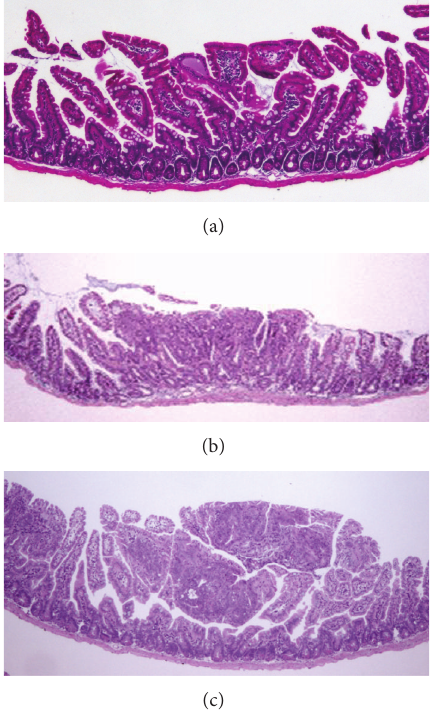
Figure 2: Histological aspects of adenomatous mucosa. H-E sec- tions from polyps with mild (a), moderate (b), and severe (c)